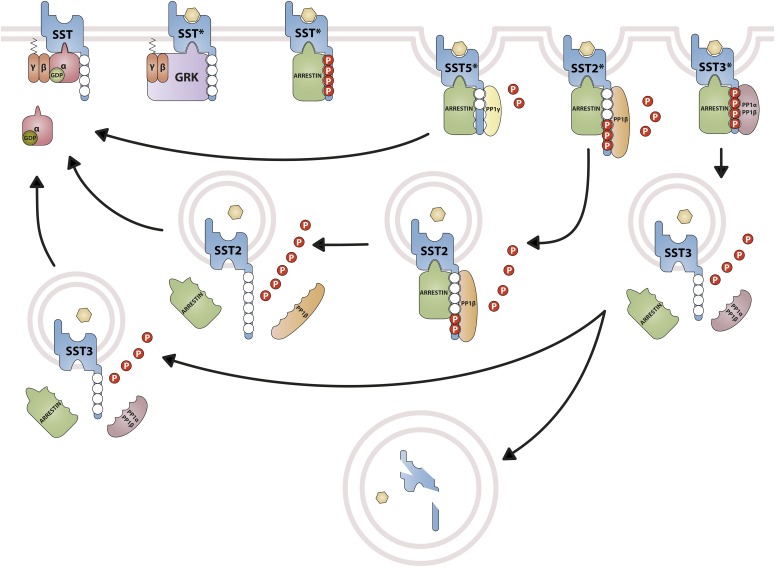
Differential trafficking of somatostatin receptors. Agonist activation of SSTs triggers activation of the associated heterotrimeric G protein that in turn stimulates a second messenger system. Quenching of this signal involves phosphorylation of the receptor by GRKs. Phosphorylation by GRKs increases the affinity for arrestins, which uncouple the receptor from the G protein and target the receptor to clathrin-coated pits for internalization. Return to its resting state requires dissociation or degradation of the agonist, dephosphorylation, and dissociation of arrestin. For SST5, the catalytic PP1γ subunit was identified to catalyze S/T dephosphorylation at the plasma membrane within seconds to minutes after agonist removal. SST5 forms unstable complexes with arrestins that are rapidly disrupted. After dephosphorylation, SST5 is either resensitized at the plasma membrane or recycled back through an endosomal pathway. For SST2, the catalytic PP1β subunit was identified to catalyze S/T dephosphorylation. SST2 forms stable complexes with arrestins that cointernalize into the same endocytic vesicles. This dephosphorylation process is initiated at the plasma membrane and continues along the endosomal pathway. PP1β-mediated dephosphorylation promotes dissociation of arrestins and, hence, facilitates quenching of arrestin-dependent signaling. Subsequently, SST2 is recycled back through an endosomal pathway to the plasma membrane. For SST3, the catalytic PP1α/β subunits were identified to catalyze S/T dephosphorylation at the plasma membrane within seconds to minutes after agonist removal. SST3 forms unstable complexes with arrestins that are rapidly disrupted. After dephosphorylation, SST3 is either subject to lysosomal degradation or recycled back to the plasma membrane through an endosomal pathway.